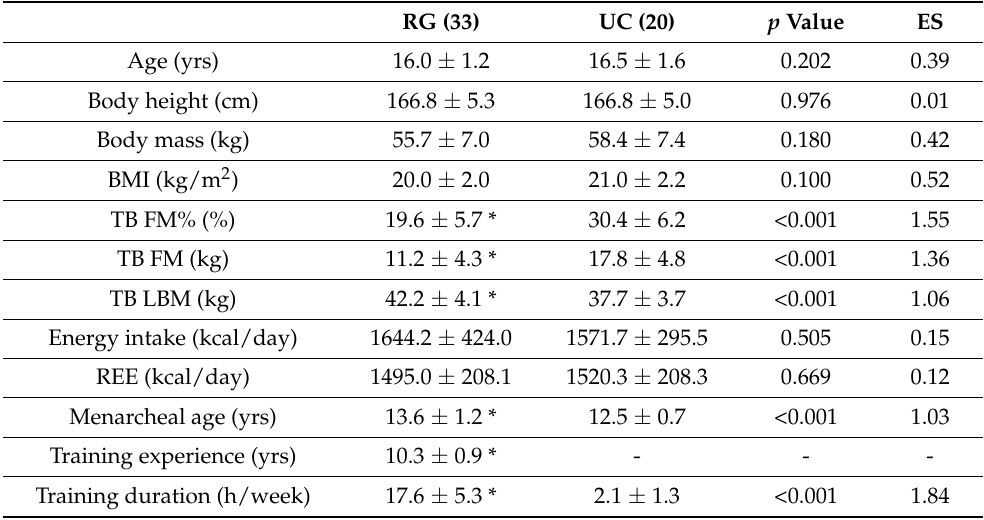
Table 1. The main characteristics and fat parameter data in the rhythmic gymnasts (RGs) and untrained controls (UCs) female groups.